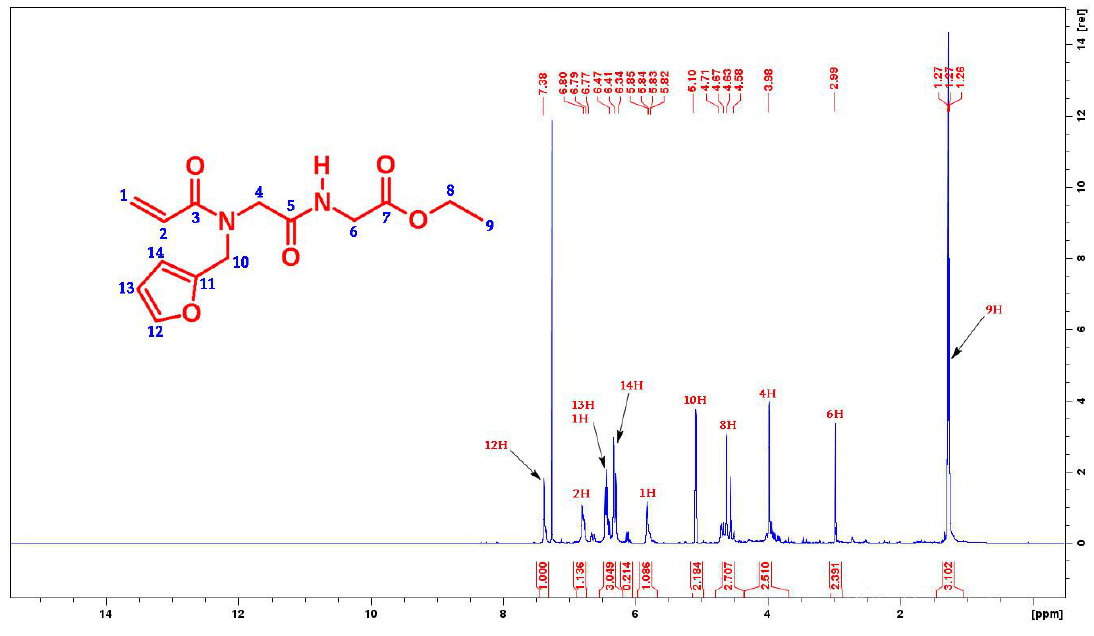
Figure 1. 1 H-NMR spectra of the title compound (700 MHz, CDCl 3 ) at room temperature.